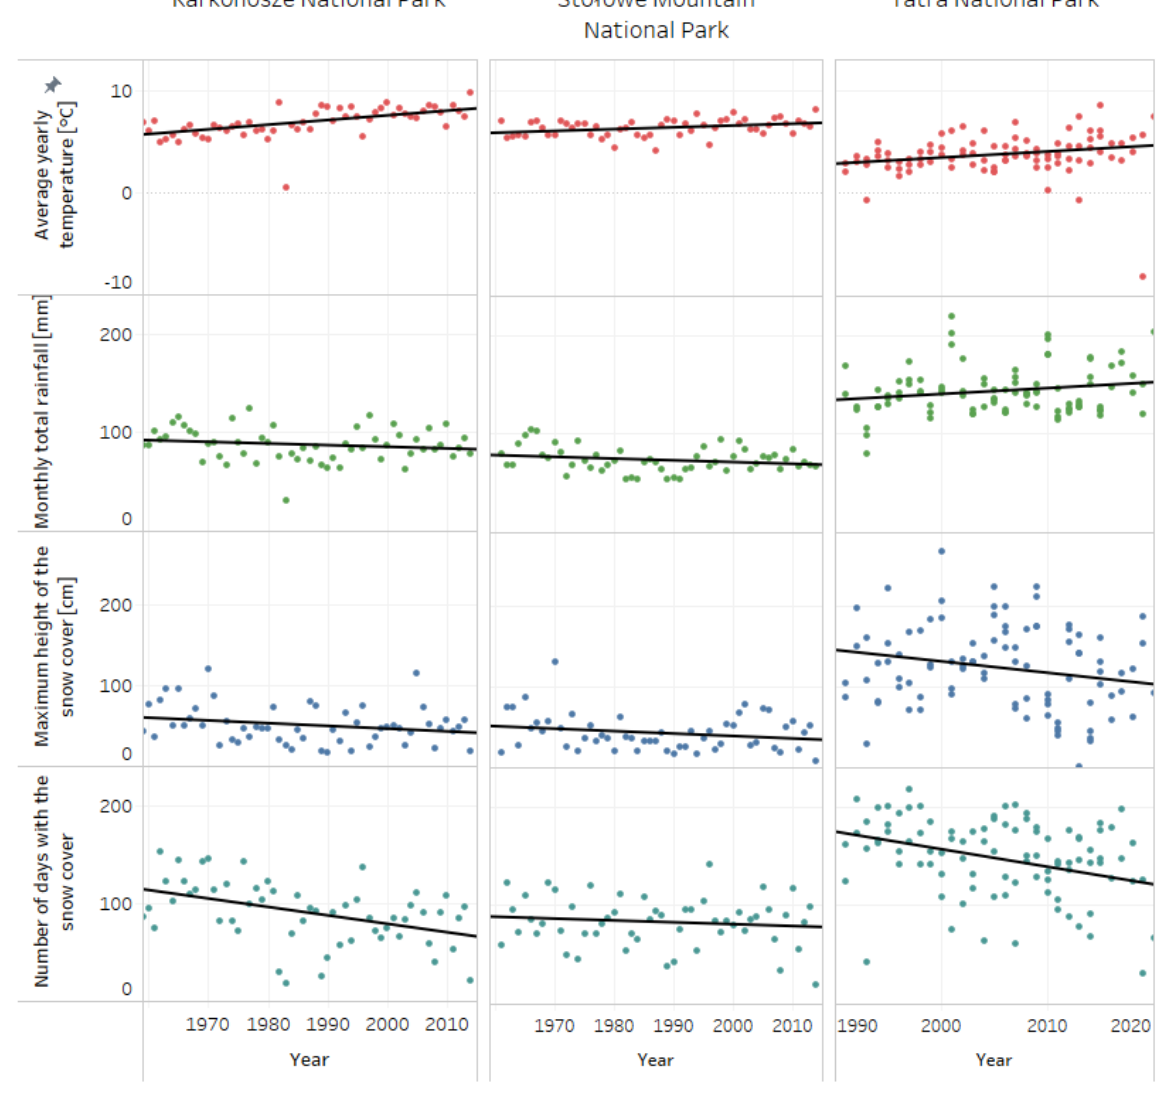
Figure 1. Annual dynamics of climatic conditions in the studied areas.